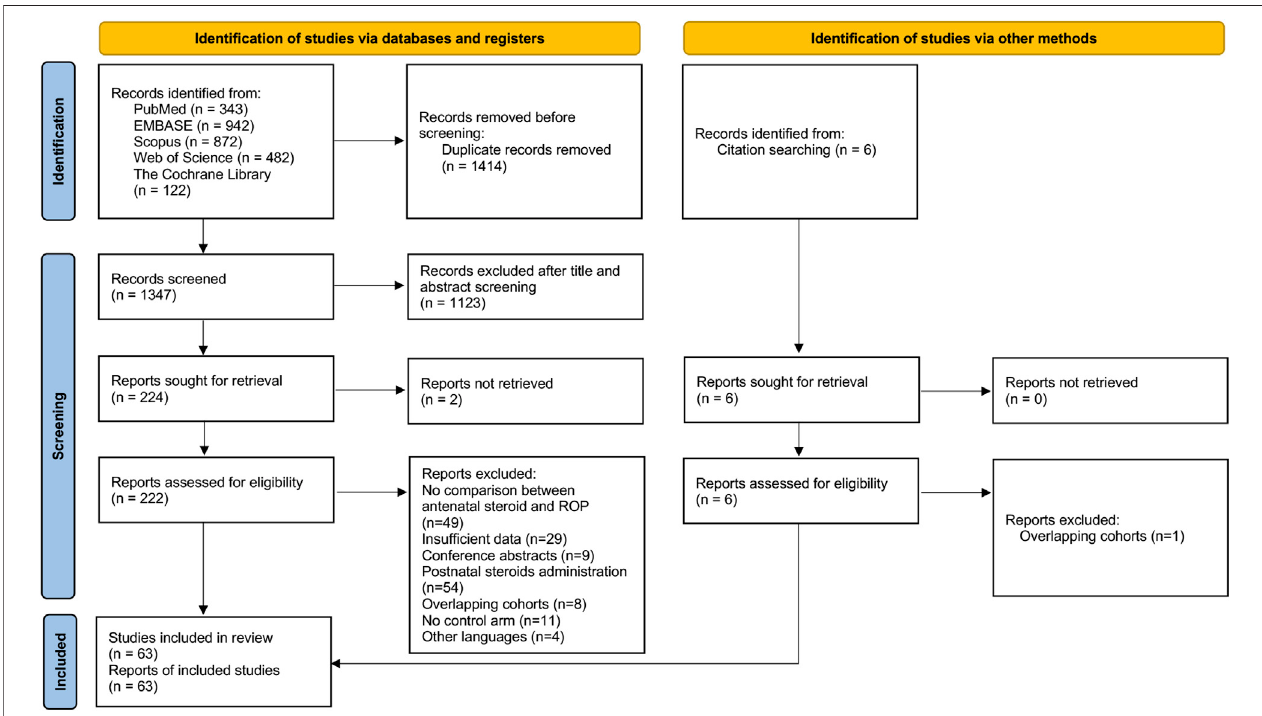
FIGURE 1 | PRISMA fl ow diagram of the systematic search